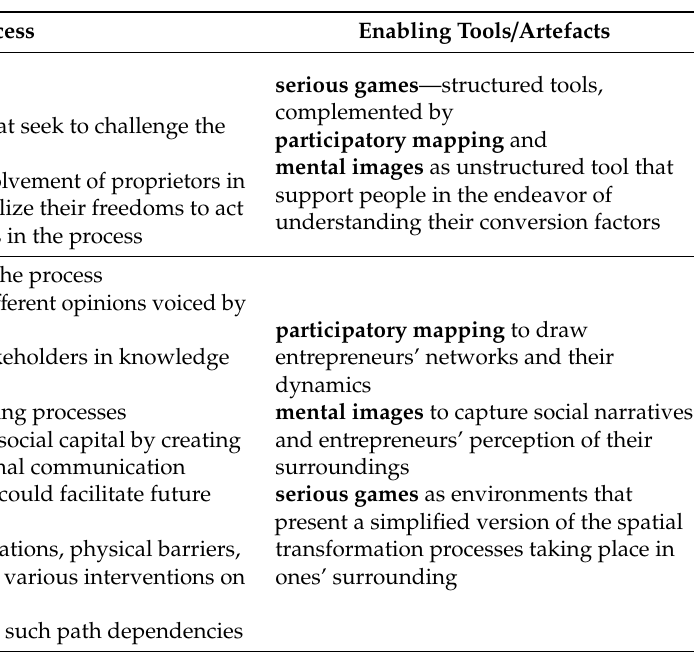
Table 5. Evaluation of the enabling artefacts within the Vennestraat capacity-building process against the Capability Approach